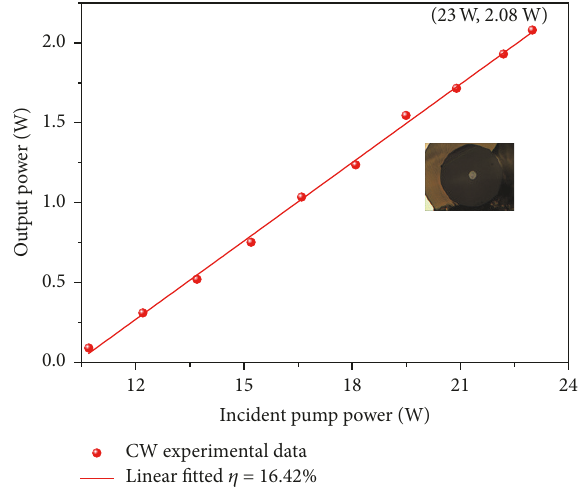
Figure 3: Continuous-wave output powers versus launched pump